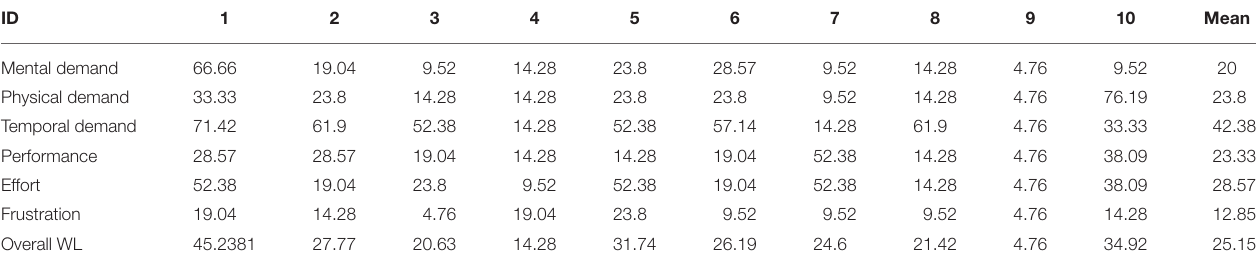
TABLE 7 | NASA TLX workload